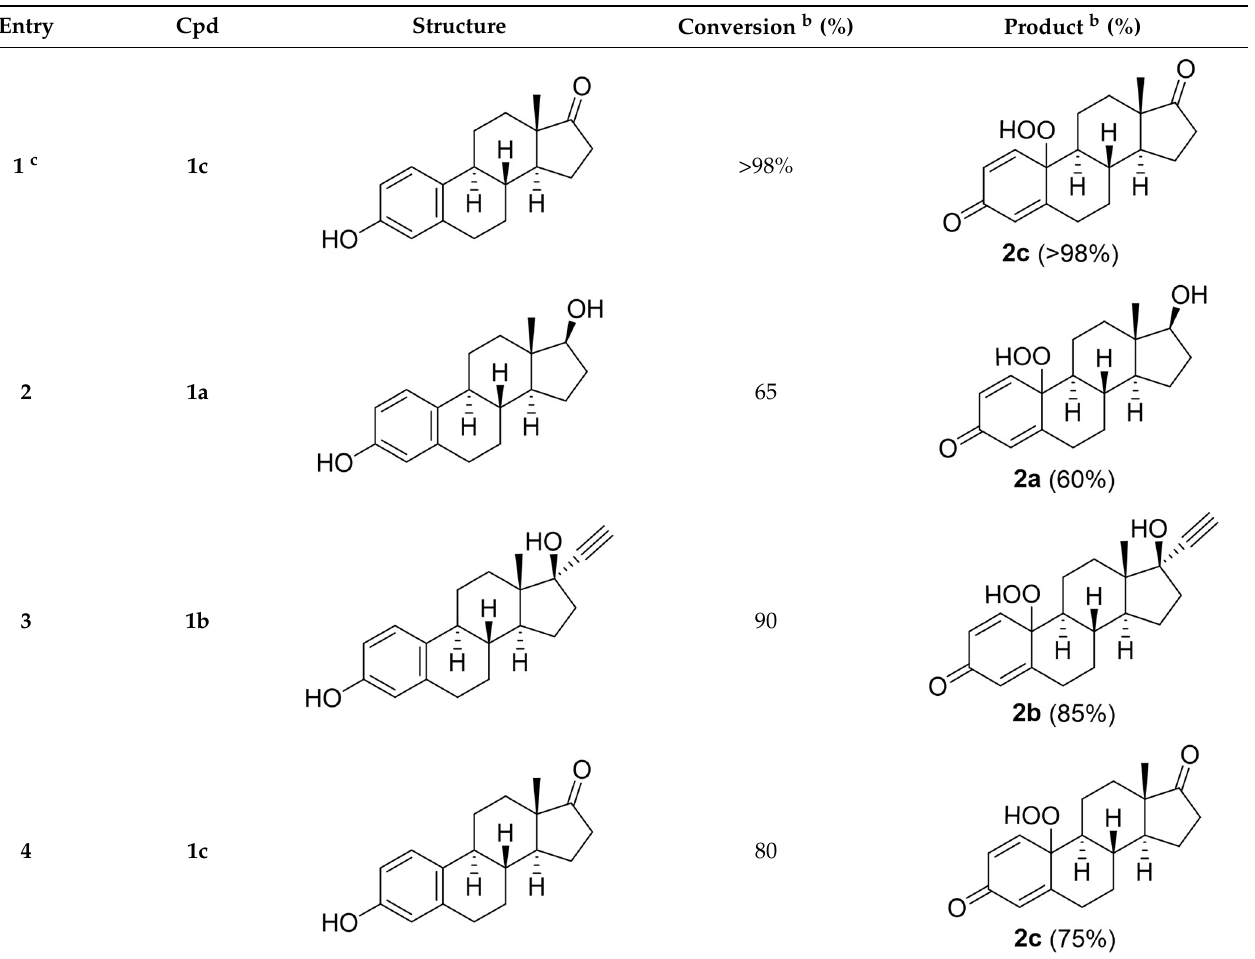
Table 3. Substrate scope of novel blue LED-driven two-liquid- phase photo-oxygenation a .